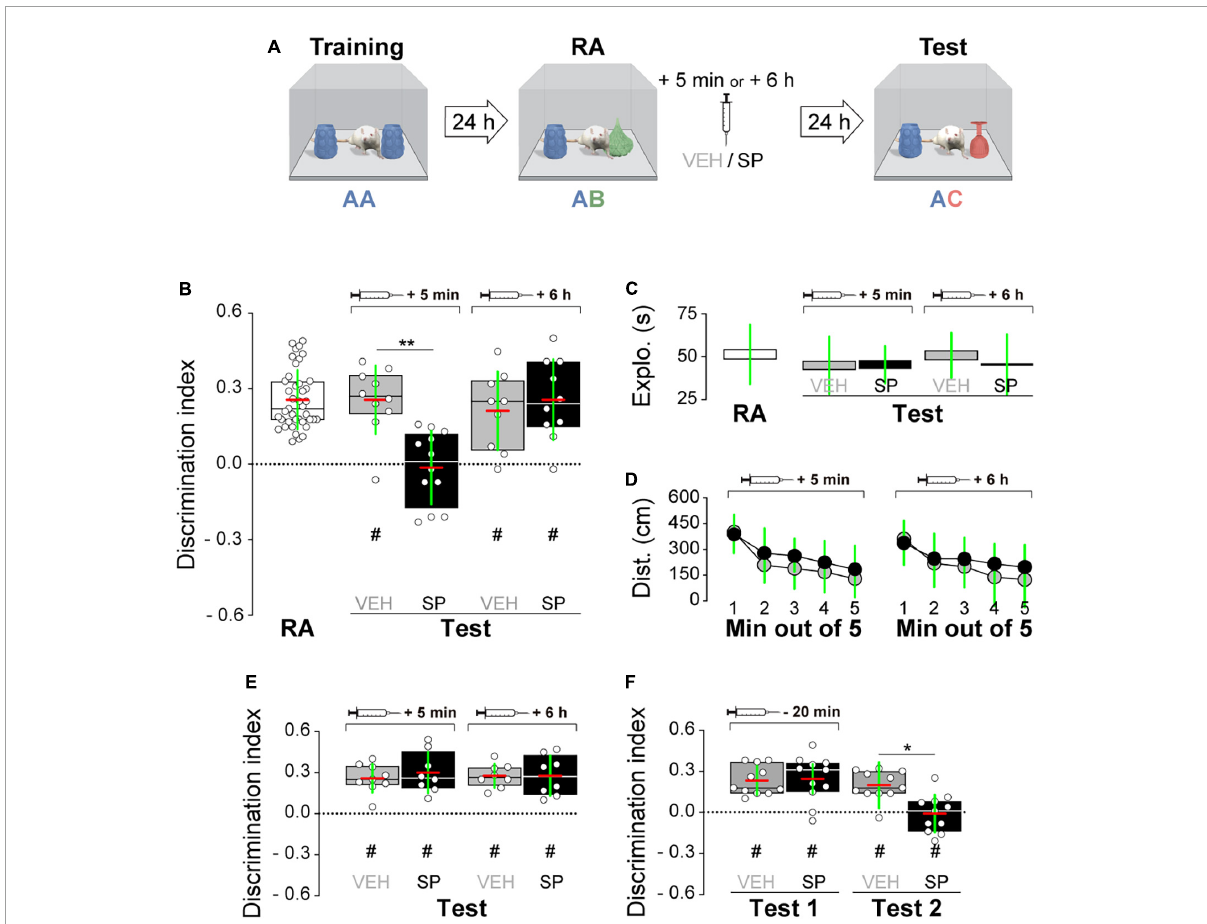
FIGURE2 (A) Experimental protocol. (B) Rats were trained in the novel object recognition (NOR) task using two copies of object A and 24 h later they were submitted to an object recognition memory (ORM) reactivation session (RA) in the presence of familiar object A and novel object B. Five min or 6 h after RA, rats received bilateral intra-dorsal CA1 injections of SP600125 (SP; 20 µ M; 1 µ l/side) or vehicle (VEH; (0.1% DMSO in sterile saline). One day later rats were exposed to familiar object A and novel object C to evaluate ORM retention (Test). (C) Total exploration time during test. (D) Mean distance traveled during test for VEH and SP-treated animals. (E) Rats were treated as in panel (A) , except that RA occurred in the presence of two copies of familiar object A. (F) Rats were treated as in panel (A) , except that the animals received bilateral intra-CA1 injections of VEH or SP 20 min before Test 1. Discrimination index (DI) data are expressed as median (black or white horizontal lines) ± interquartile range (boxplots) and as mean (red horizontal line) ± SD (green vertical line). Dashed lines represent chance level. Total object exploration and distance traveled data are presented as mean ± SD. n = 8–12 animals per group; # p < 0.05 in one-sample Student’s t -test with theoretical mean = 0; and * p < 0.05 and ** p < 0.01 in Bonferroni’s multiple-comparison test after two-way